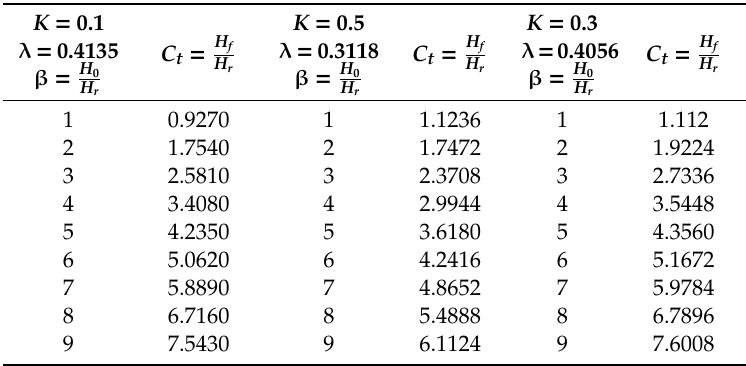
on the coating H r